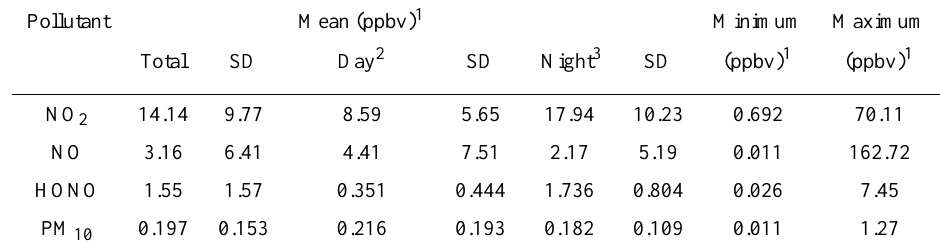
Table 2. Pollutants in Kathmandu urban air.